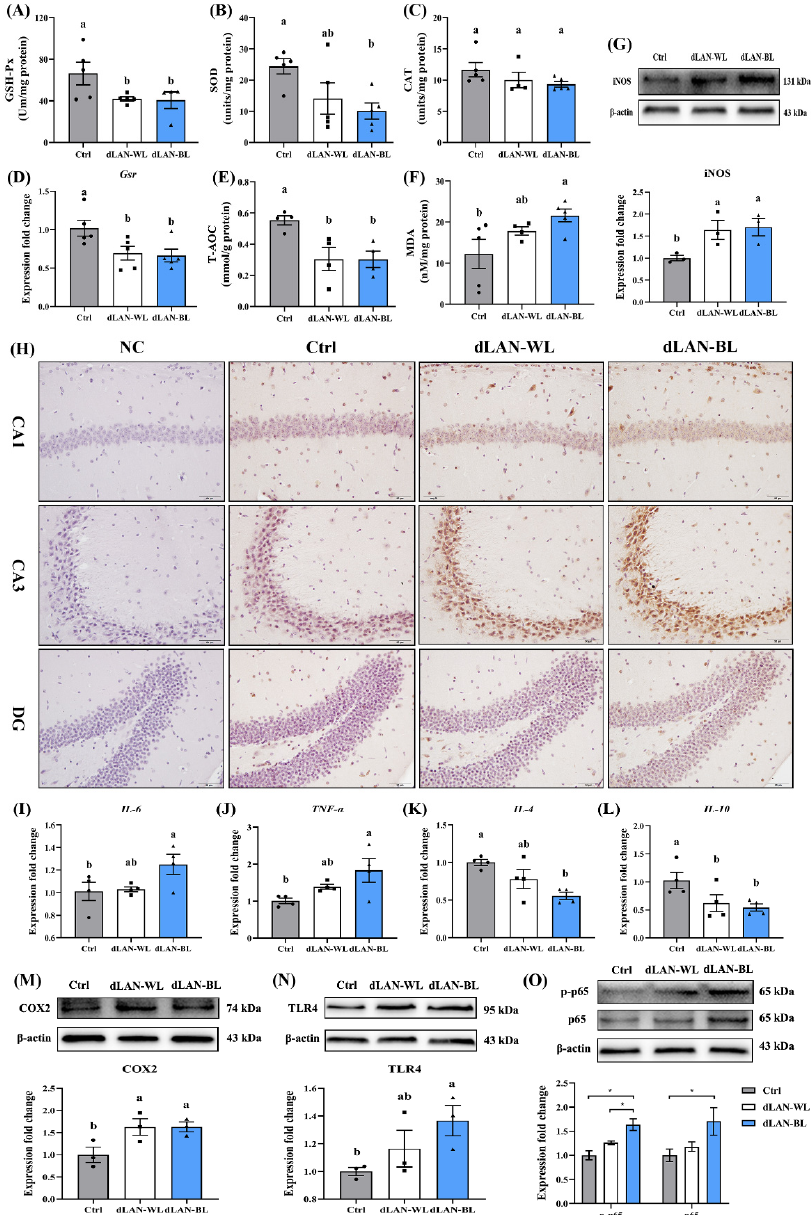
Figure 3. Effects of dim blue light at night on oxidative stress and inflammation in the hippocampus. ( A ) The levels of GSH-Px in the hippocampus ( n = 5). ( B ) The levels of SOD in the hippocampus ( n = 5). ( C ) The levels of CAT in the hippocampus ( n = 5). ( D ) The mRNA levels of Gsr in the hippocampus ( n = 5). ( E ) The levels of T-AOC in the hippocampus (n = 5). ( F ) The levels of MDA in the hippocampus ( n = 5). ( G ) Relative levels of iNOS in the hippocampus ( n = 3). ( H ) Images of the immunohistochemical iNOS in the different experimental groups. Bar =50 µm. ( I ) The mRNA levels of cytokines IL-6 in the hippocampus ( n = 4). ( J ) The mRNA levels of cytokines TNF- α in the hippocampus ( n = 4). ( K ) The mRNA levels of cytokines IL-4 in the hippocampus ( n = 4). ( L ) The mRNA levels of cytokines IL-10 in the hippocampus ( n = 4). ( M ) Relative levels of COX2 in the hippocampus ( n = 3). ( N ) Relative levels of TLR4 in the hippocampus ( n = 3). ( O ) Relative levels of p-p65 and p65 in the hippocampus ( n = 3). Differences were assessed using one-way ANOVA. The result represents the mean ± standard error of the mean. Values not sharing a common superscript letter (a,b) or marking (*) differ significantly at p < 0.05; those with the same letter (a,b) do not differ significantly ( p ≥ 0.05). Ctrl: control group, dLAN-WL: dim white light at night group, dLAN-BL: dim blue light at night